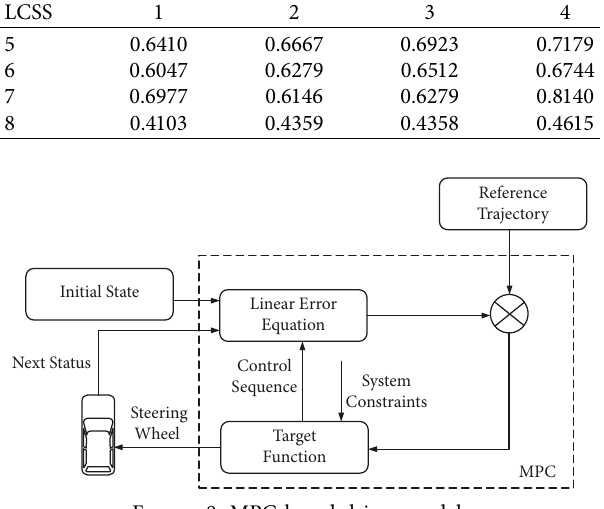
Figure 8: MPC-based driver